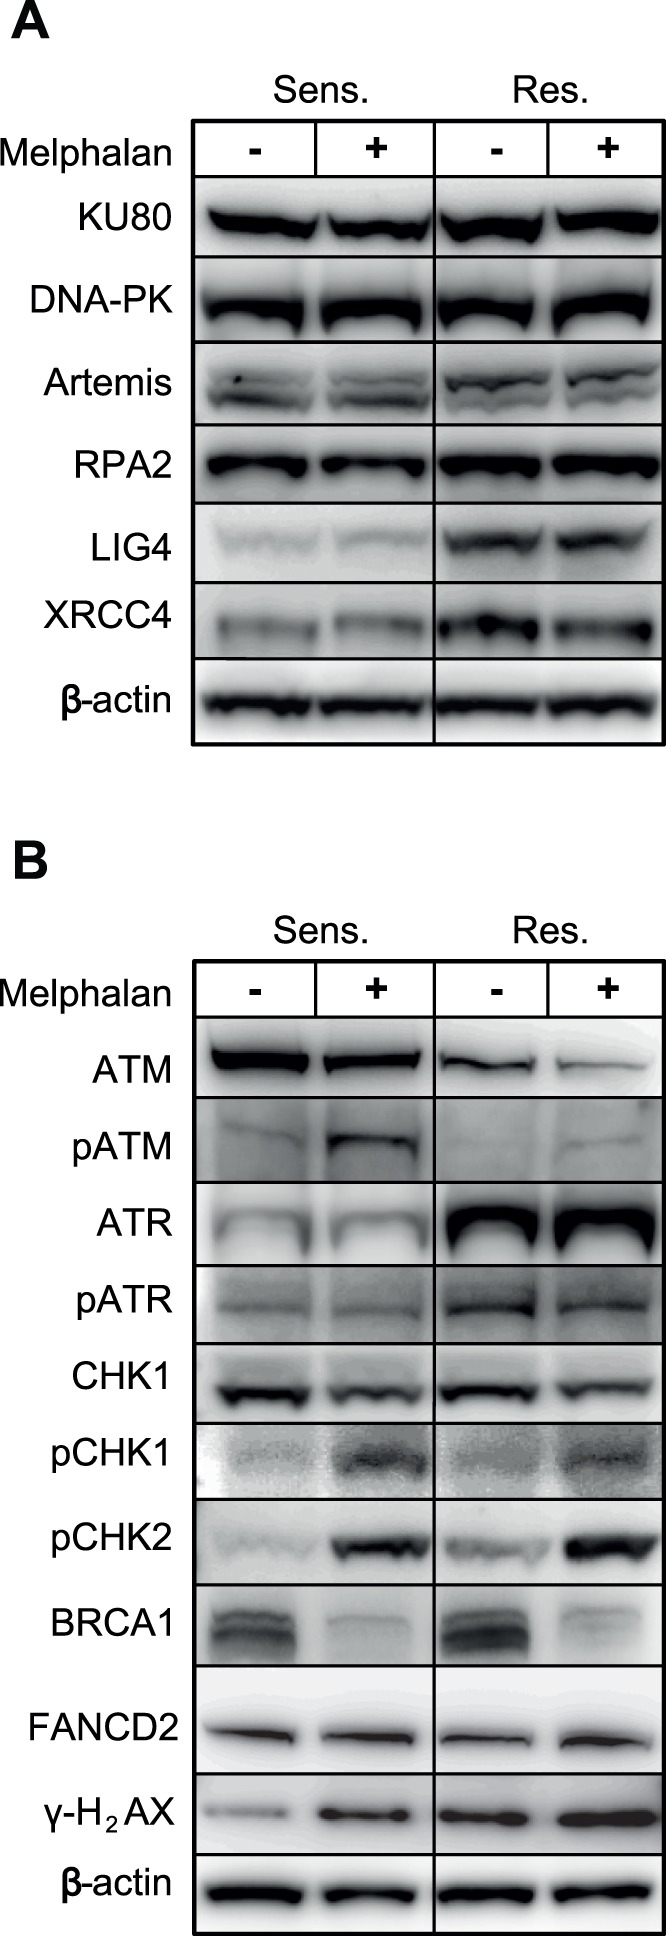
Level of DNA repair proteins (A) and damage signaling kinases (B) involved in DSB repair in Melphalan-sensitive and -resistant cells.(A) Quantitative western blot analysis revealed that the NHEJ proteins DNA ligase IV, XRCC4 and RPA2 are significantly and constitutively upregulated in Melphalan-resistant cells. In addition, KU80 and phosphorylated Artemis was consistently, although not significantly upregulated. Exposure to high dose Melphalan did not mediate further alteration of NHEJ proteins in the cell lines. (B) The steady-state levels of the kinase ATR and its phosphorylated form are increased in Melphalan resistant cells. Conversely, ATM is constitutively downregulated in the same cells. Rather than activation of CHK1, increased steady-state phosphorylation of pCHK2 was observed in resistant cells. Notably, high dose Melphalan strongly activates CHK2 in both sensitive and resistant cells but was consistently higher in resistant cells. Moreover, BRCA1, which is slightly induced in resistant cells, becomes markedly reduced in both sensitive and resistant cells after high dose Melphalan indicating temporary downregulation of HRR. Also note the the lack of apparent monoubiquitinylation of FANCD2 (B). β-actin was used as reference for quantitative analysis.